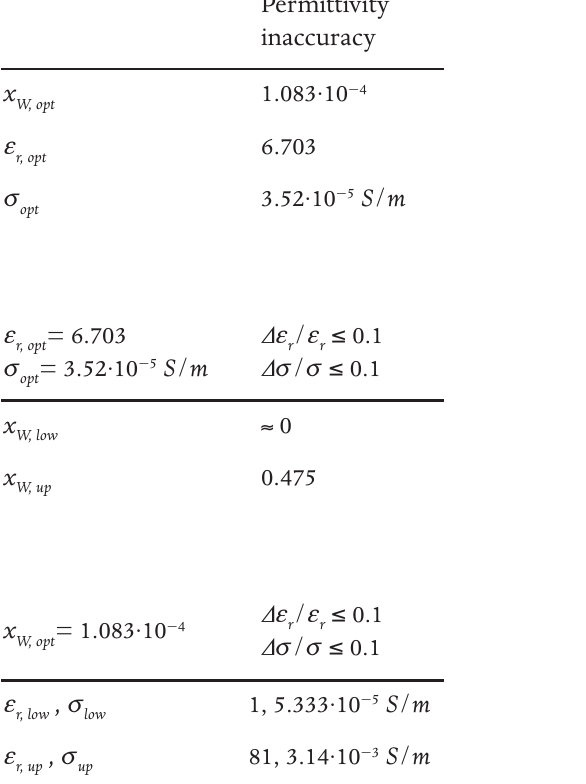
, f , v ) of W, opt r, opt opt / f ≤ 0.1 and Dv / v ≤ 0.1, r r and v ; (c) domains of f and v where r, opt opt